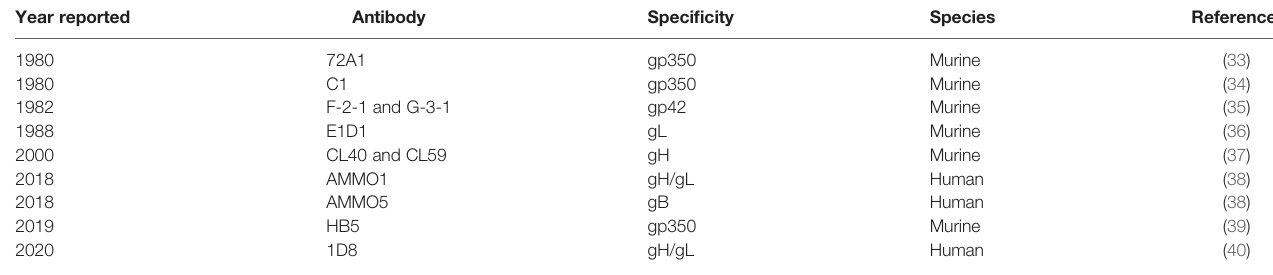
TABLE 1 | List of EBV glycoprotein-speci fi c monoclonal nAbs.